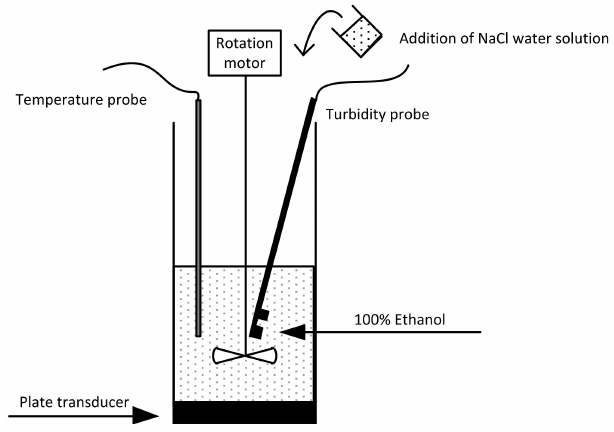
Figure 2. A schematic diagram of the setup used in this